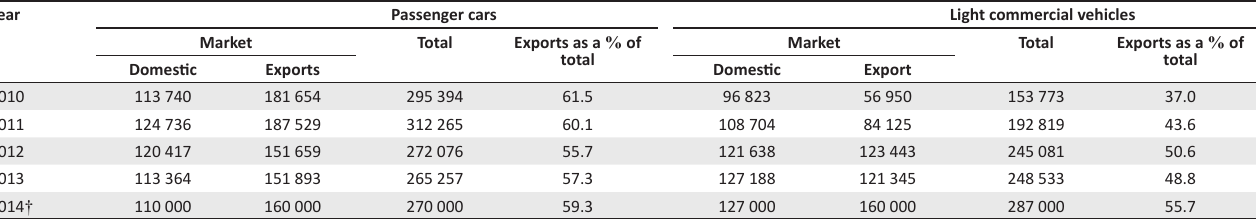
TABLE 1: Export statistics of passenger cars and light commercial vehicles. Year Passenger